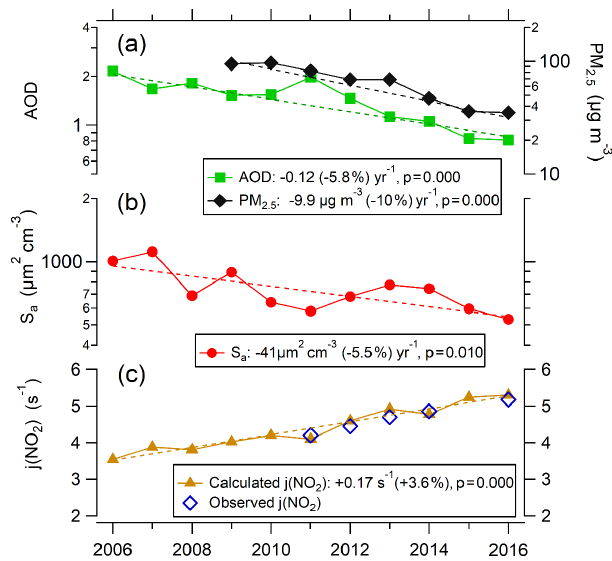
Figure 6. Variations in daytime (07:00–19:00) averages of AOD (380nm), PM 2 . 5 , S a , J( NO 2 ) calculated J( NO 2 ) by TUV in Bei- jing in August between 2006 and 2016. AOD and J( NO 2 ) are both corresponding to cloudless weather. On the y axes, a log scale is used for PM 2 . 5 , AOD, and S a , and a linear scale is used for J( NO 2 ) .